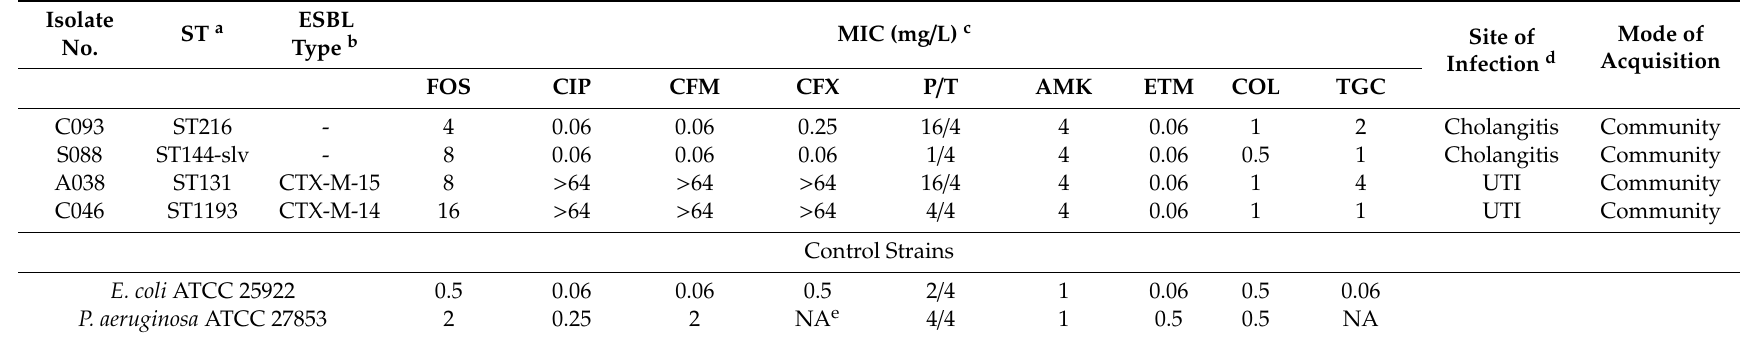
Table 3. Characteristics of E. coli isolates selected for time-kill